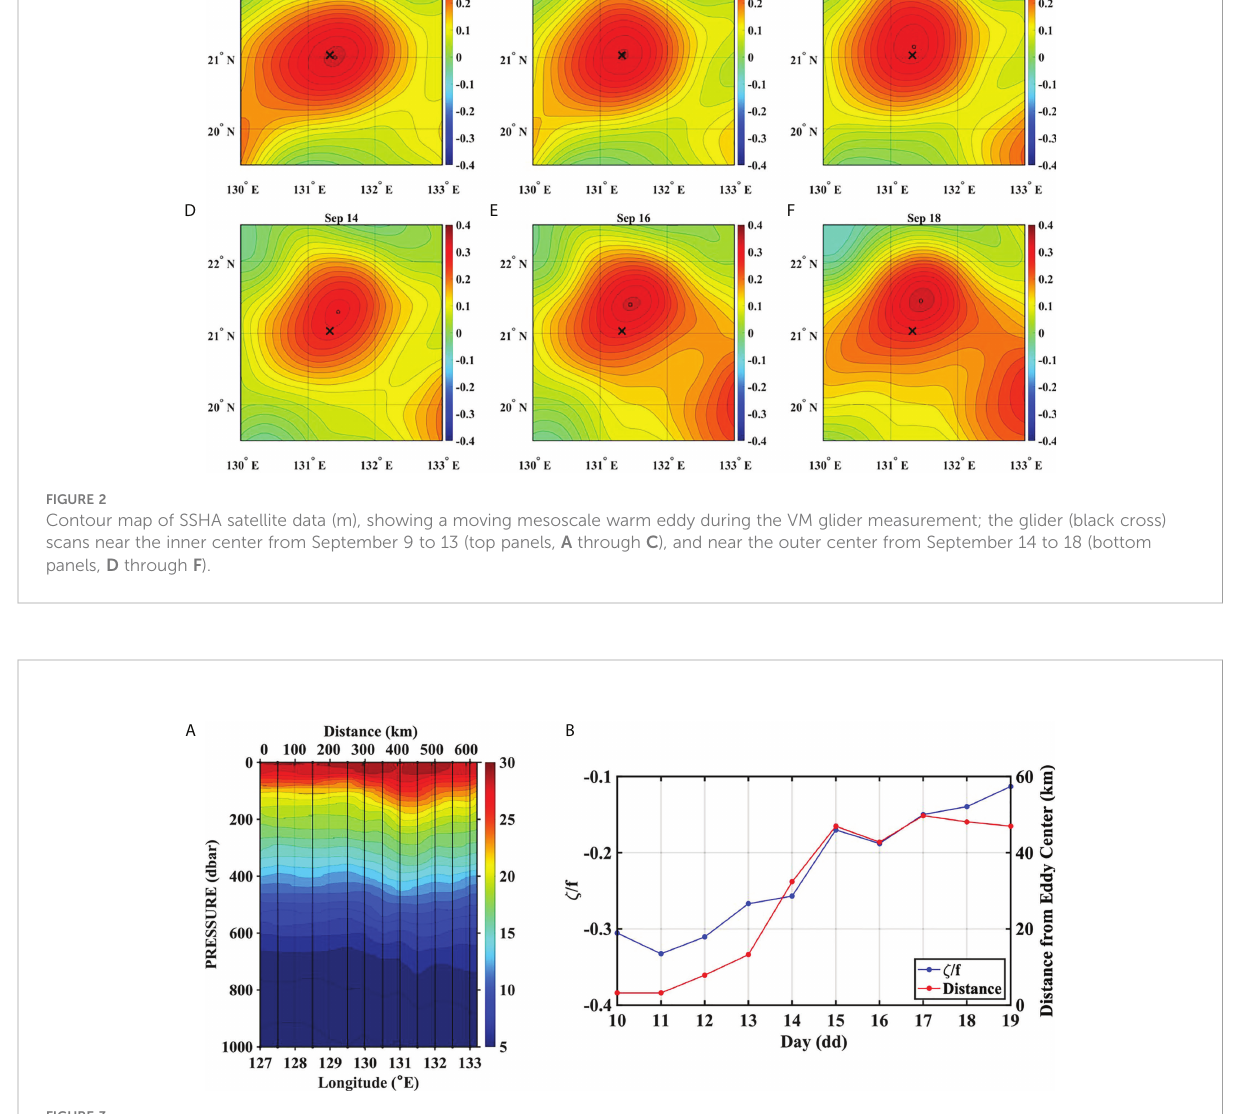
FIGURE 3 (A) The horizontal – vertical map of temperature variations along with isothermal curves obtained from CTD observations of the R/V ISABU represents the spatial structure of the eddy in the longitudinal range over approximately 130.5°E to 132.5°E; the bottom of the eddy reaches